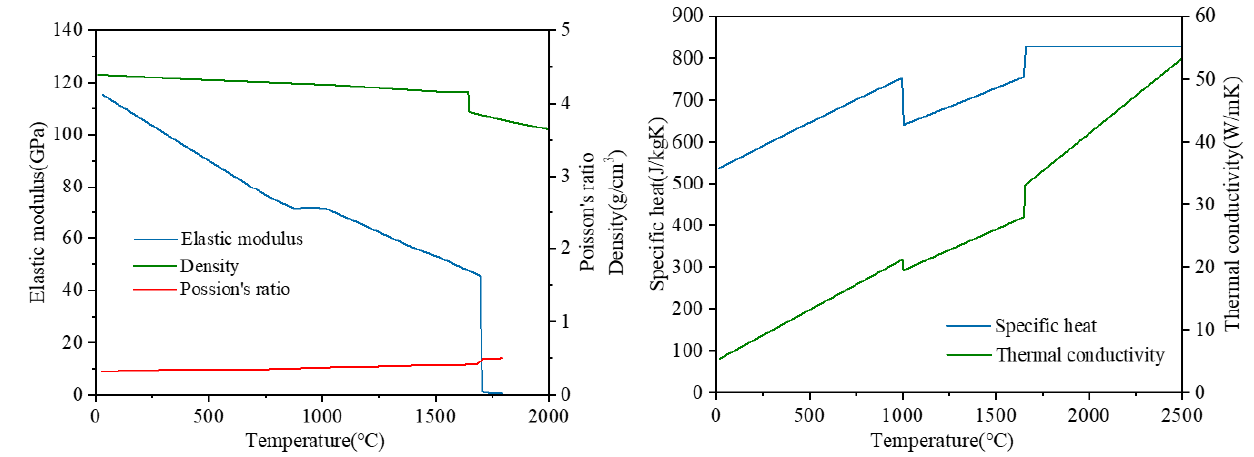
Figure 1. Thermo-physical properties of Ti-6Al-4V with temperature. In order to obtain the stress – strain relationship of the Ti-6Al-4V titanium alloy at different temperatures, a tensile test was carried out with a strain rate of 0.001 s −1 in a wide temperature range (20~1000 °C), and the tensile properties of Ti-6Al-4V varying with temperature were obtained, as shown in Figure 2 [9].